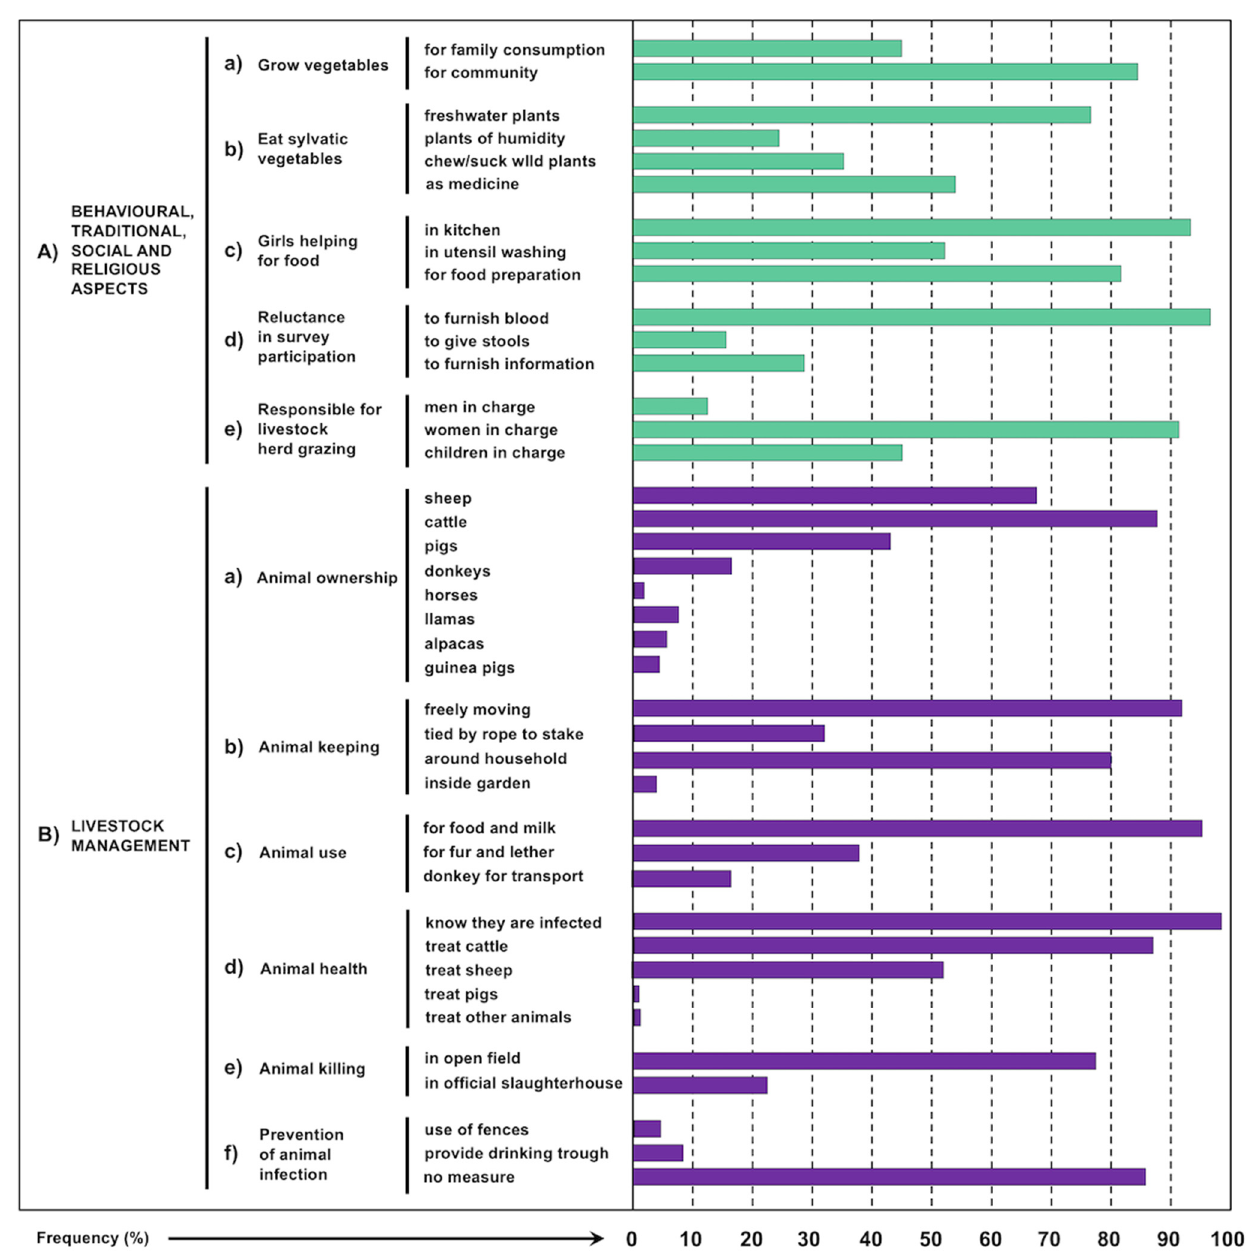
Figure 9. Results (%) of the quantitative analyses of the characteristics of 23 Aymara communities presenting human infection by Fasciola hepatica , covering all zones of the human fascioliasis hyperendemic area in the Northern Bolivian Altiplano with transmission foci in each endemic inter-hilly flat corridor or transect, including information obtained in the ethnographic fieldwork, during all seasons and throughout a very long period of 35 years, about aspects linked to fascioliasis transmission and human infection: ( A ) behavioural, traditional, social and religious aspects; ( B ) livestock management.